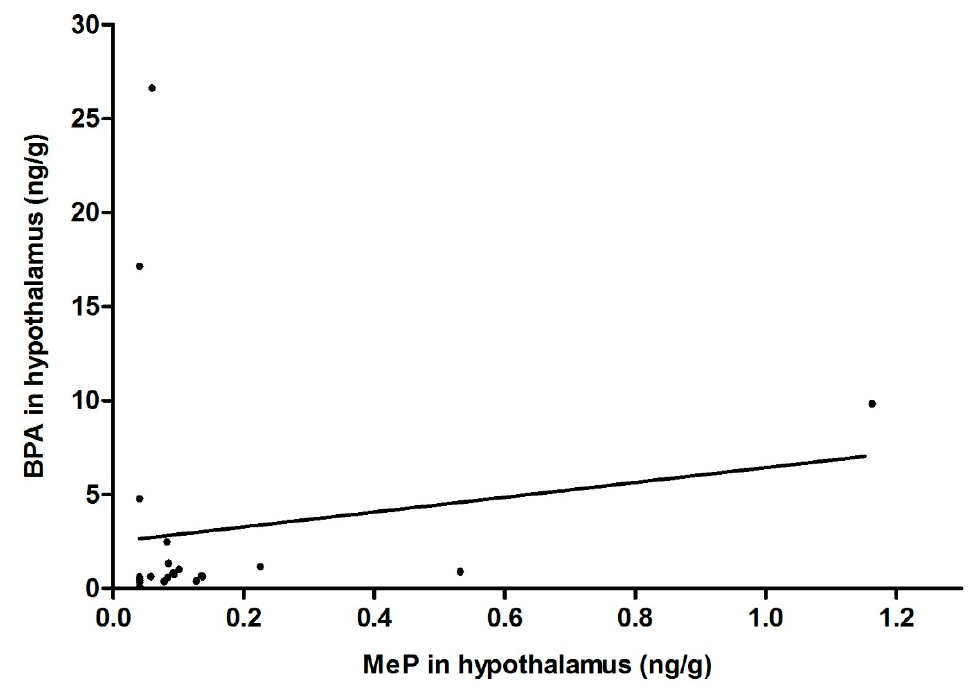
Figure 2. Correlation between BPA and MeP concentrations in the hypothalamus (Spearman correlation coefficient r = 0.37, p = 0.078).